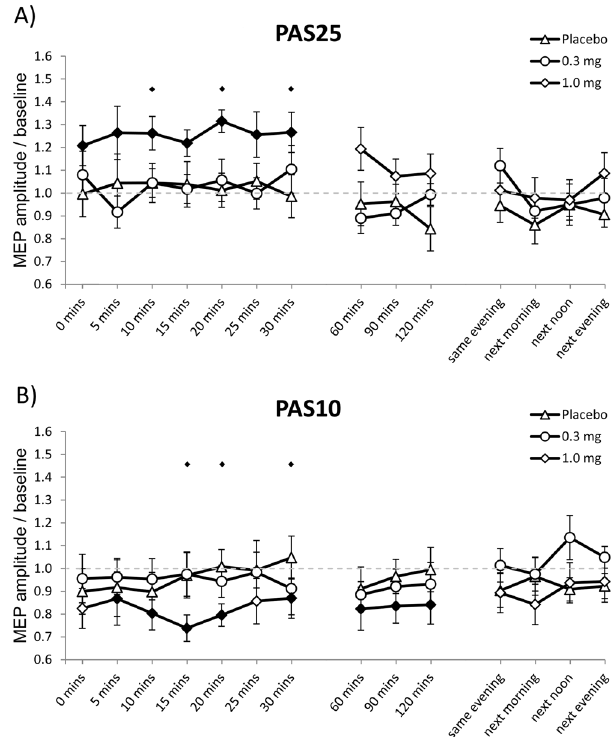
Figure 4. Impact of varenicline on PAS-induced neuroplasticity. Shown are baseline-normalized MEP amplitudes after plasticity induction by PAS25 ( A ) and PAS10 ( B ) under 0.3 mg, 1.0 mg varenicline or placebo medication conditions up to the evening of the post-stimulation day. Both, PAS25 and PAS10 induce no changes of MEP amplitudes in smokers under placebo or 0.3 mg varenicline conditions. ( A ) Cortical excitability was significantly enhanced for up to 30 minutes under high dose varenicline after PAS25 administration. ( B ) High dose varenicline restored inhibitory plasticity after PAS10. Error bars indicate S.E.M. Filled symbols indicate significant differences of post-stimulation MEP amplitudes from respective baseline values; floating symbols indicate significant differences between the respective drug and placebo medication conditions at the same time points (Student’s t-test, two tailed, paired samples, p <